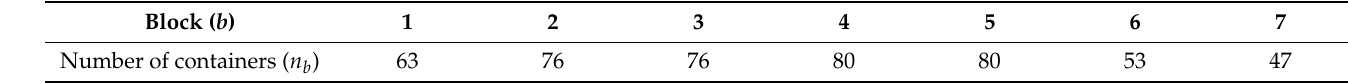
Table 7. The number of containers to be picked up from each yard block in instance 8.